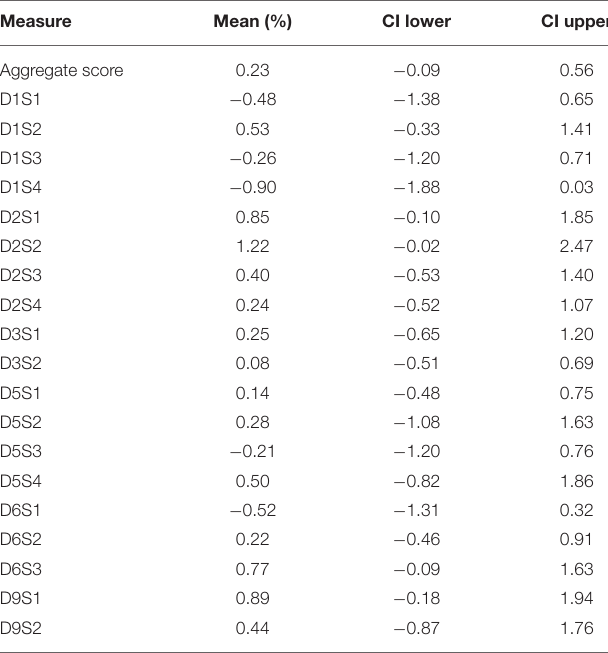
TABLE 3 | Lead executive education levels and population size of LHDs that were accredited and those that were not from among LHDs in the UCOA data. N =